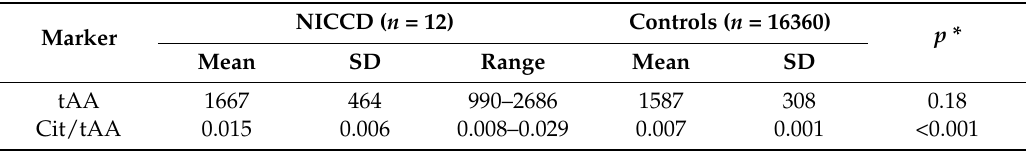
Table 3. Comparison of total amino acids and citrulline/total amino acids between missed patients with NICCD and controls